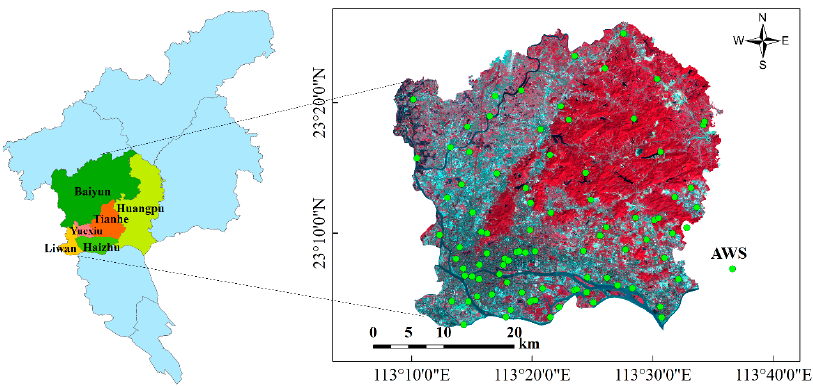
Figure 1. Location of the main urban area of Guangzhou. AWS: automatic weather station.